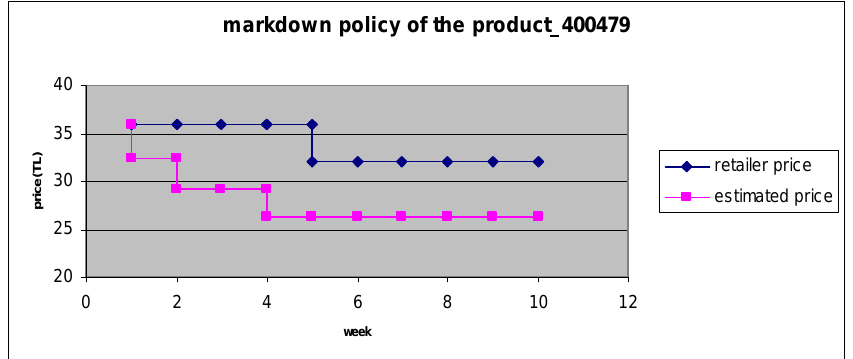
Fig. 10. Comparison between the retailer and estimated